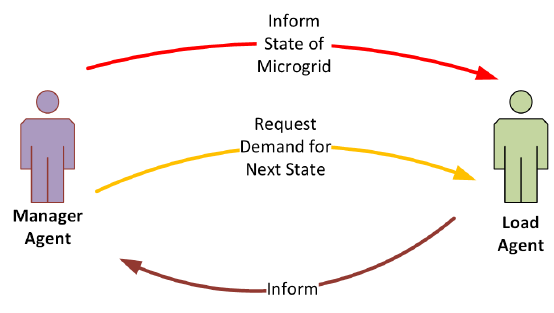
Figure 8. New Demand Request and